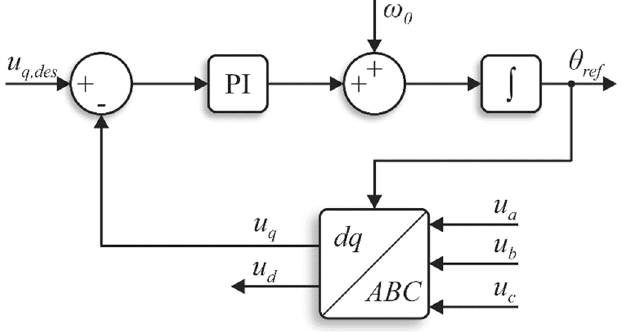
Figure 4. Phase-locked loop.